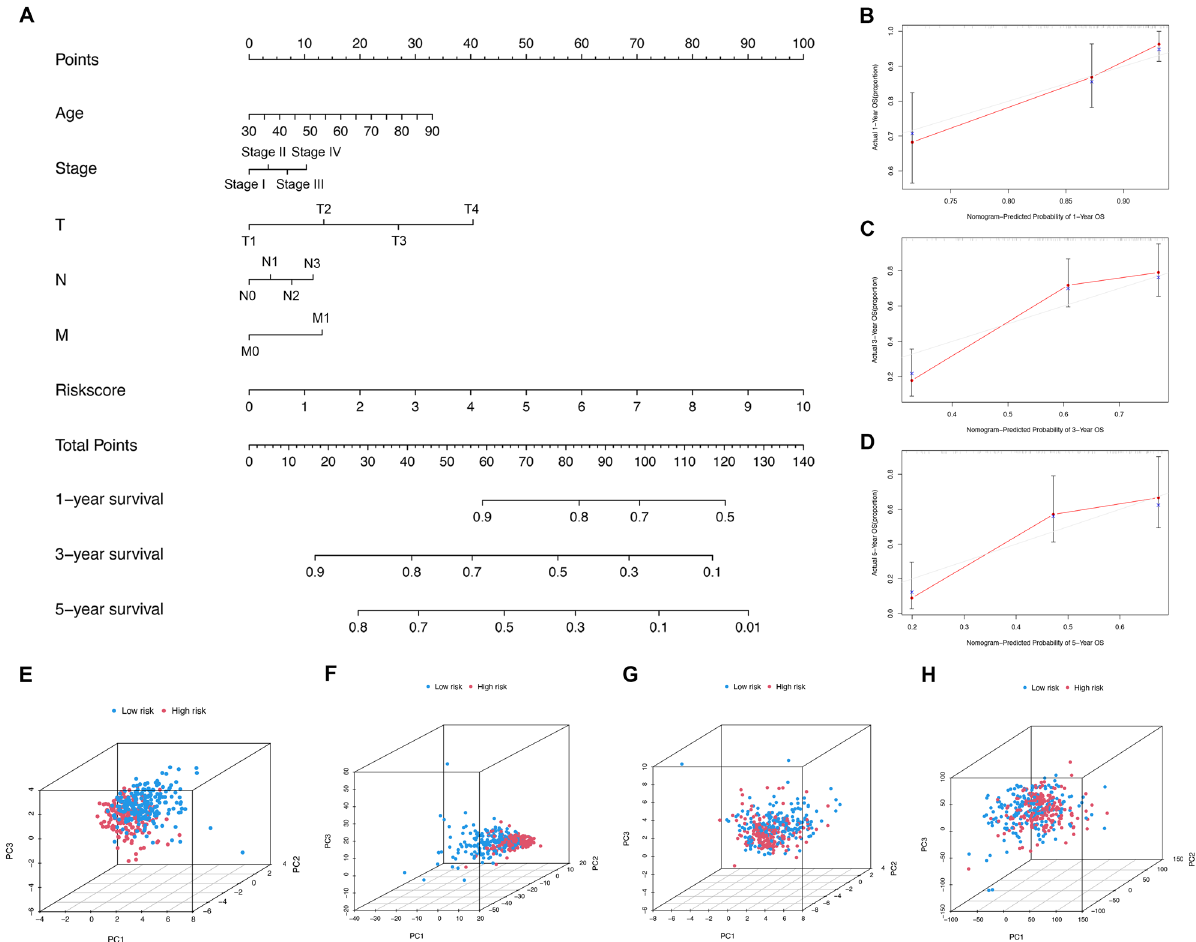
1-year OS calibration curve. ( C ) The nomogram’s 3-year OS calibration curve. ( D ) The nomogram’s 5-year OS calibration curve. ( E ) Principal component analysis (PCA) of the signature-related lncRNAs. ( F ) PCA of the m7G-related lncRNAs. ( G ) PCA of the m7G-related genes. ( H ) PCA of the all